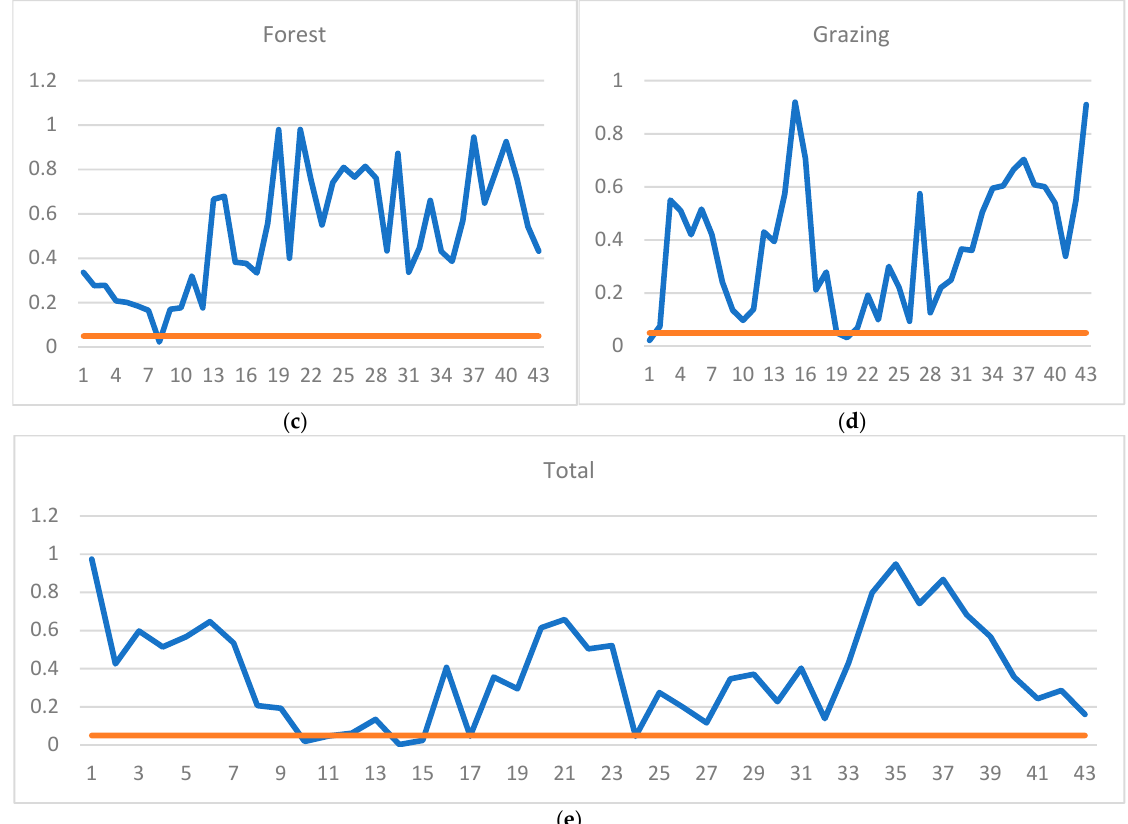
Figure 2. Intercept and Trend Model Results, five different panel for footprints can be seen; panel ( a ): Cropland, panel ( b ): Fishing Footprint, Panel ( c ): Forest Footprint, Panel ( d ): Grazing Land Footprint and Panel ( e ): Total Footprint.